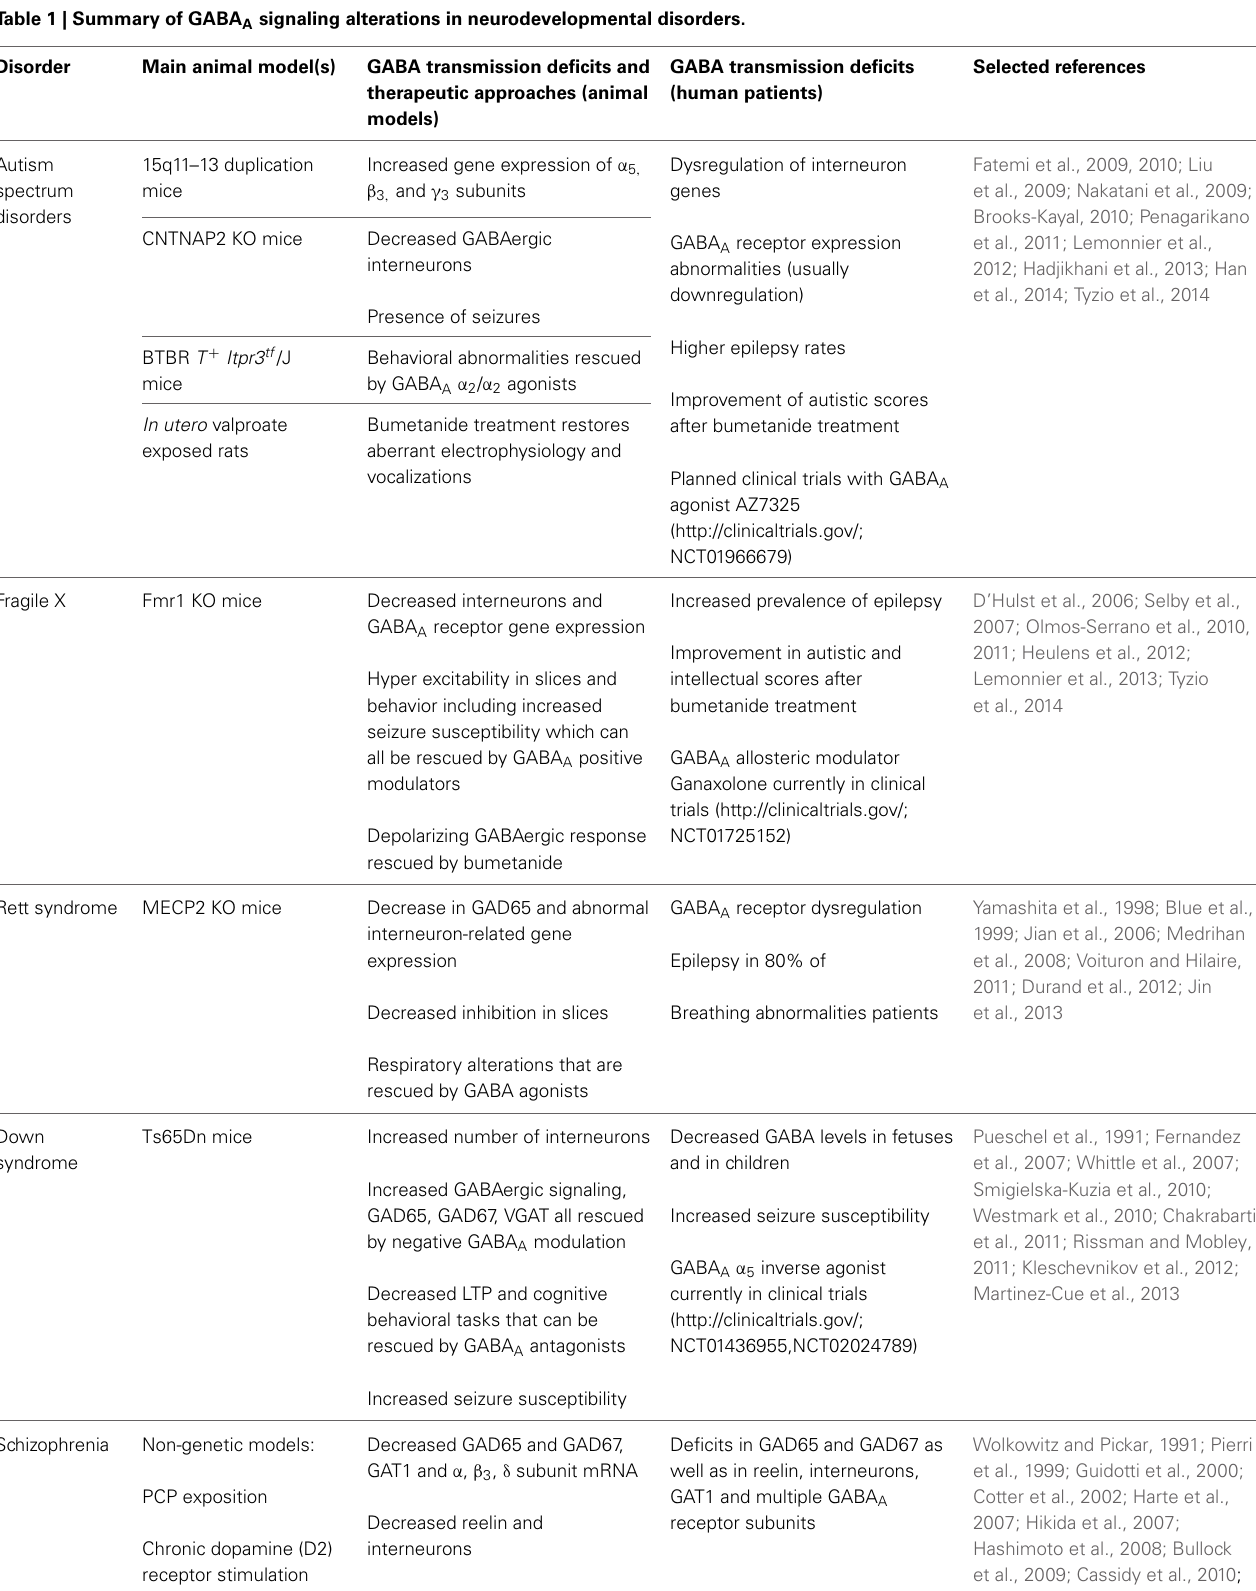
Table 1 | Summary of GABA A signaling alterations in neurodevelopmental